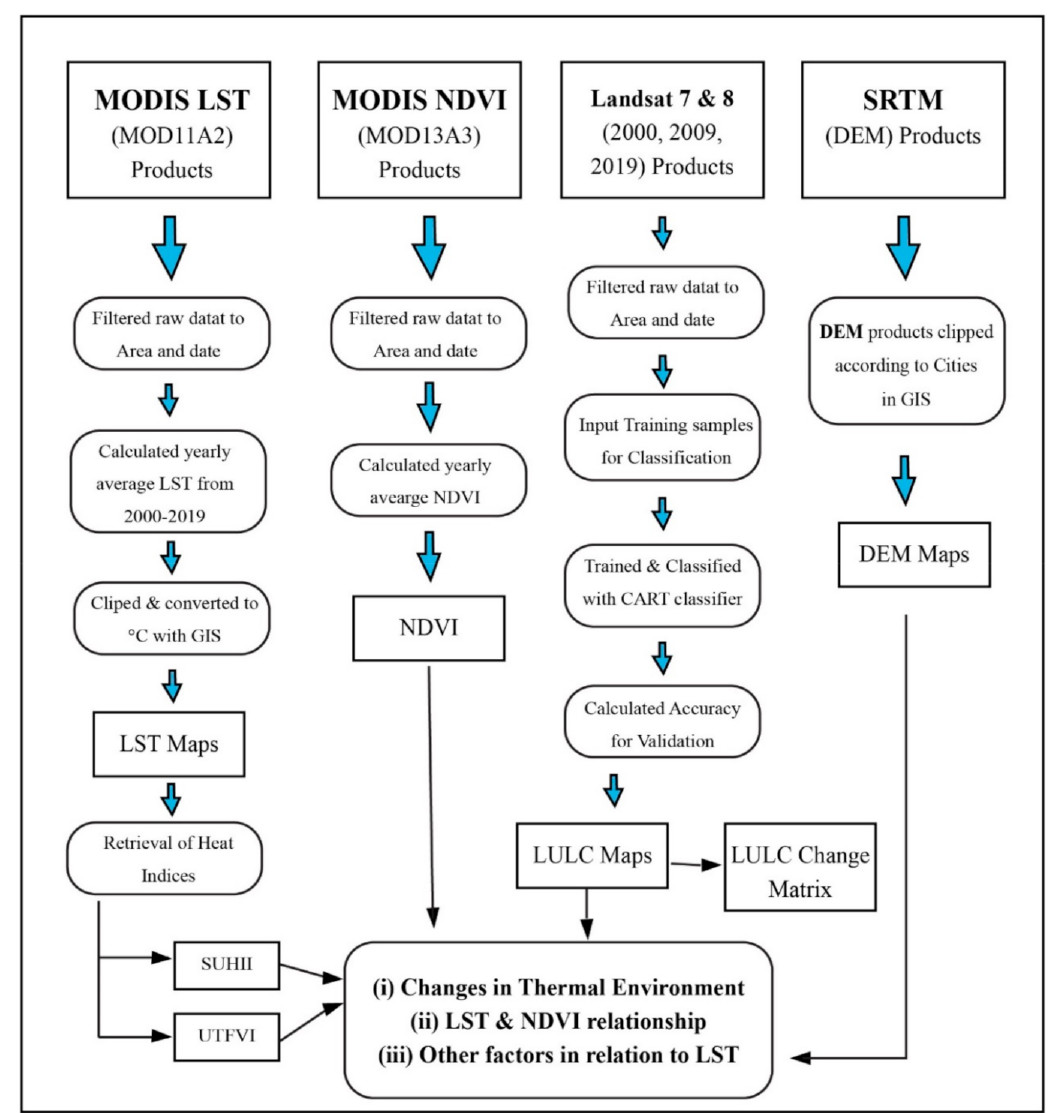
Figure 2. Flowchart of the